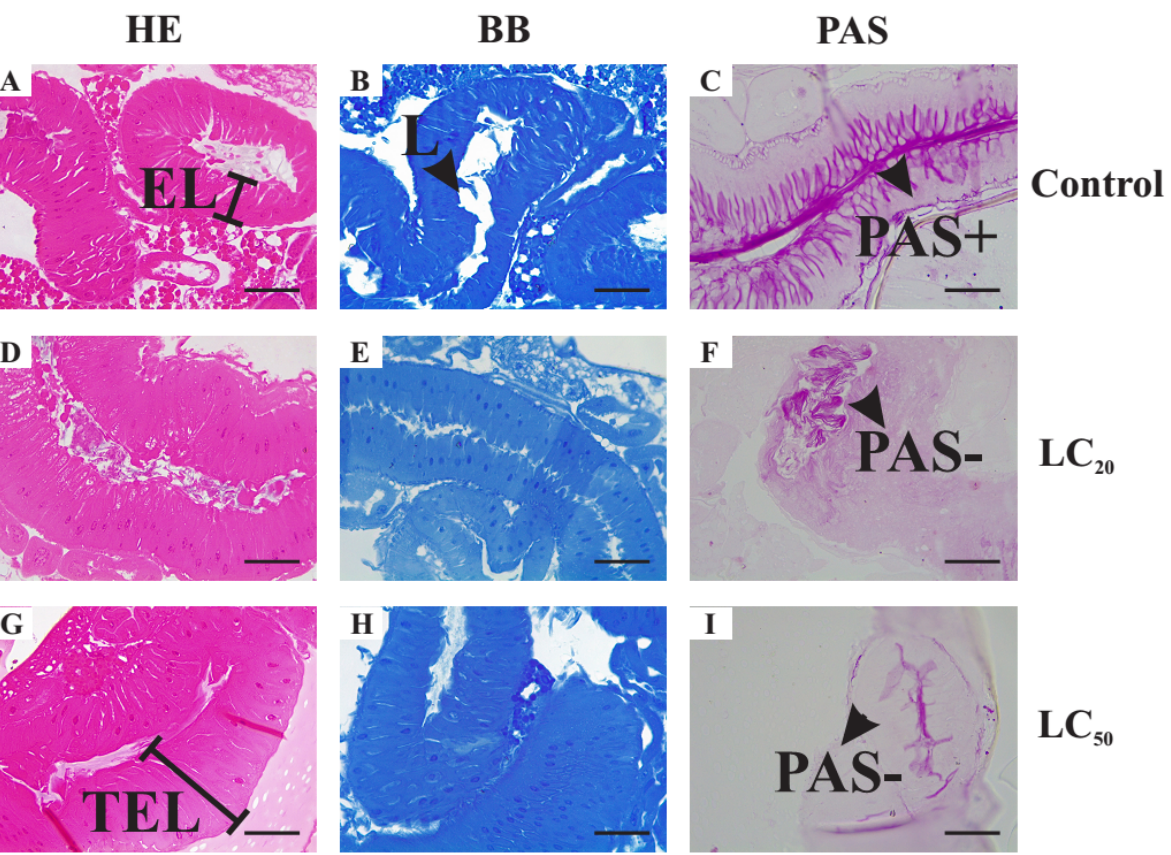
Figure 2. Histological sections of midgut of adult Drosophila suzukii females stained with Hematox ‐ ylin and Eosin (HE) ( A – G ), Bromophenol blue (BB) ( B , E , H ) and periodic acid–Schiff technique (PAS) ( C , F , I ). Control Group II (C II) ( A – C )—3% DMSO solution. Treatment group I ( D – F )—1 µ L mL − 1 (LC 20 ) of the essential oil of Illicium verum diluted in 3% DMSO. Treatment group II ( G – I )—2 µ L mL − 1 (LC 50 ) of the essential oil of I. verum diluted in 3% DMSO. Scale bars: 50 µ m. Legends: EL—epithelium length; L—midgut lumen; PAS − —PAS negative region (please note that the intestinal content is always PAS-positive, but the enterocytes are PAS negative in treatment groups); PAS + —PAS-positive region; TEL—thicker epithelium